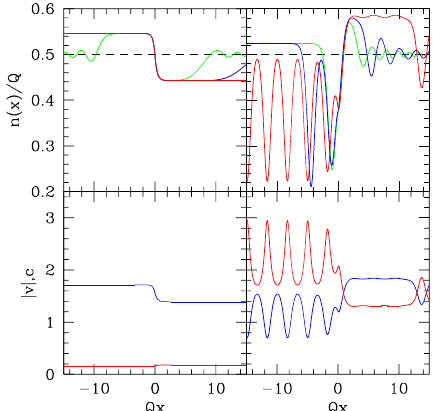
Figure 6. Top panels: time evolution of the density profile according to the GPE dynamics for a left Q . The dashed line shows the initial condition. Green, blue and red lines moving fluid with k F = π 2 correspond to evolution times t = 2,10,50 respectively for k 0 = 0 (left panel) and k 0 = k F (right panel). The time unit is τ = m . Lower panels: fluid velocity (red) and sound speed (blue) at the latest time ¯ hQ 2 for k 0 = 0 (left) and k 0 = k F (right). Velocities are in unit of ¯ hQ m